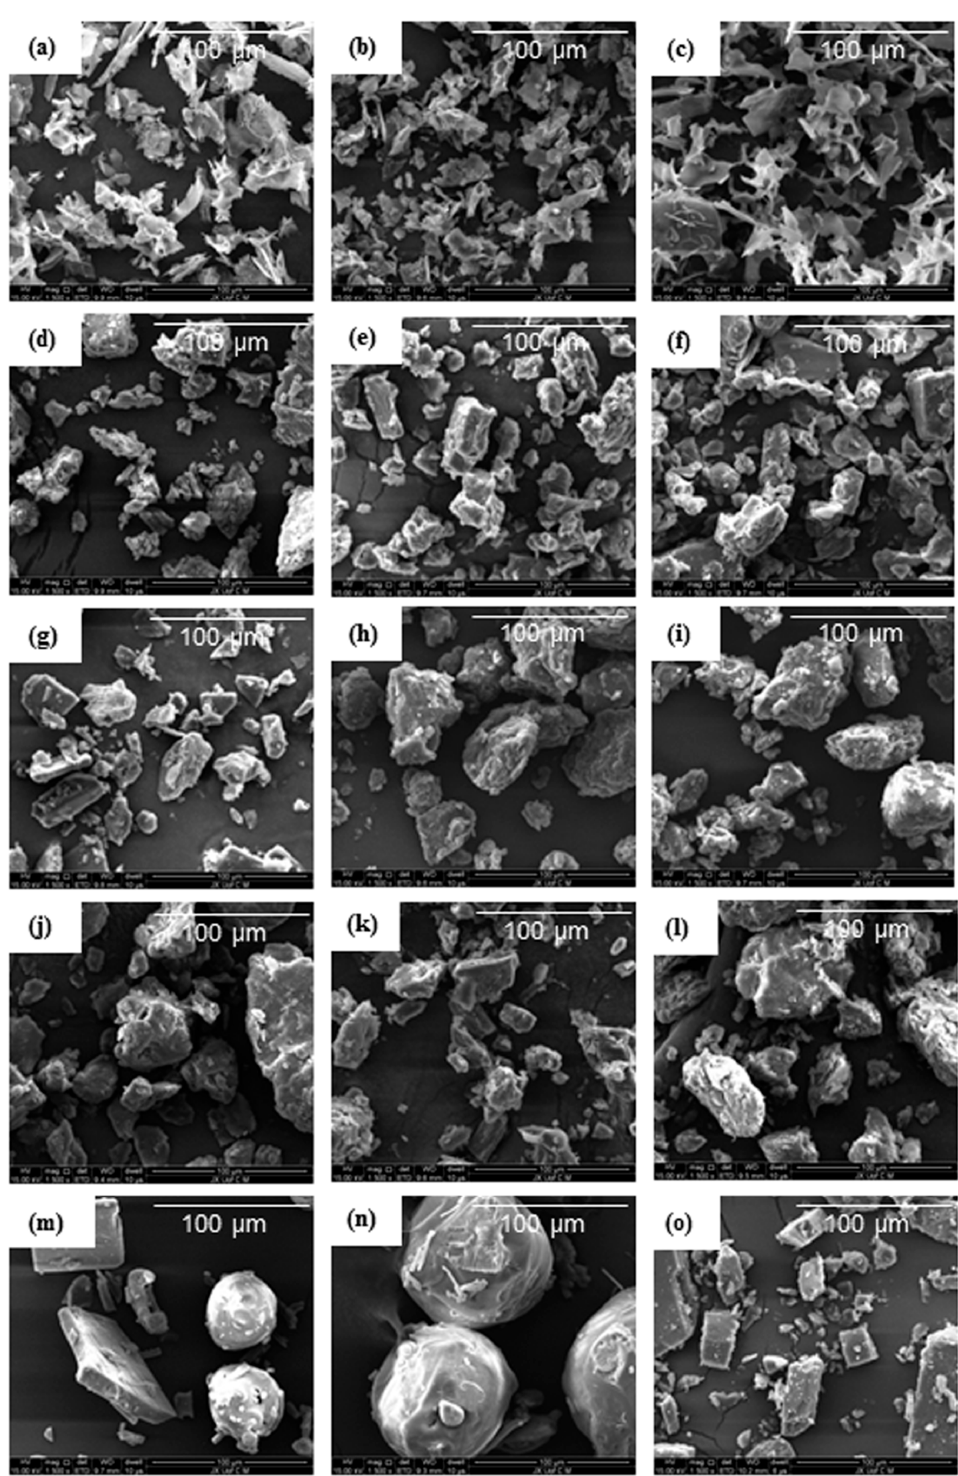
Figure 6. Scanning Electron Microscopy photographs of pure andrographolide (AG), carrier materials (PEG4000, PEG8000, SM1, and SM6), physical mixtures (PM), and solid dispersions (SD): ( a ) AG–PEG4000–S–SD, ( b ) AG–SM1–S–SD, ( c ) AG–SM6–S–SD, ( d ) AG–PEG4000–V–SD, ( e ) AG–SM1–V–SD, ( f )AG–SM6–V–SD, ( g ) AG–PEG4000–PM, ( h ) AG–SM1–PM, ( i ) AG–SM6–PM, ( j ) PEG4000, ( k ) SM1, ( l ) SM6, ( m ) AG–PEG8000–PM, ( n ) PEG8000, ( o )